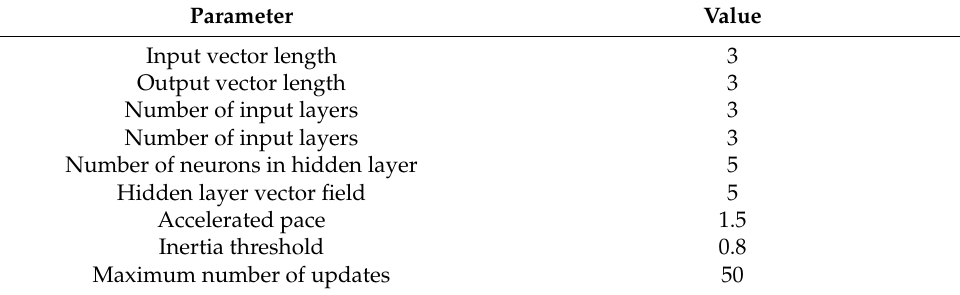
Table 1. Experiment setting